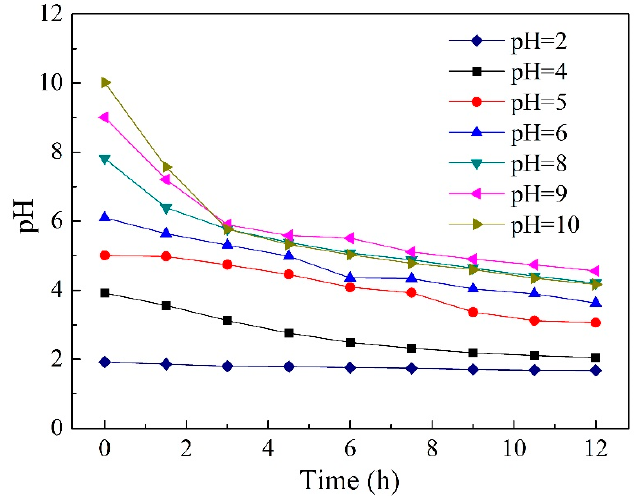
Figure 7. The change of pH in the feed solution at different initial pH values during the experiment (PIMs: PIM4; Feed solution: 0.01 mol L − 1 acetic acid + 0.01 mol L − 1 hexanoic acid; Stripping solution: 0.1 mol L − 1 HCl).